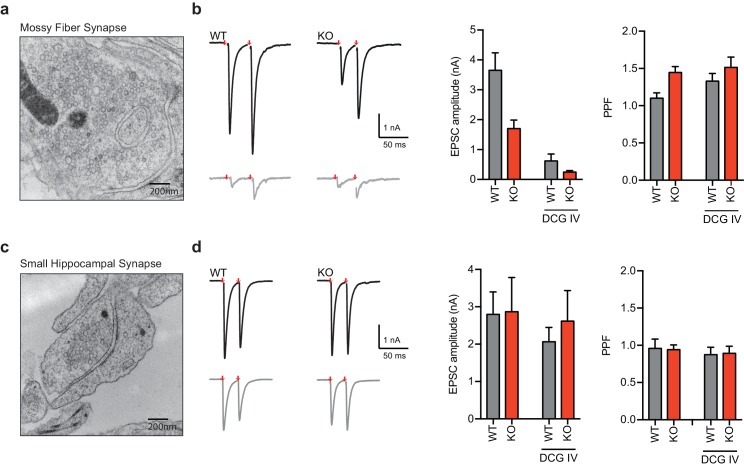
Characterization of autaptic granule cells.(a) Representative EM image of a granule cells in culture. (b) Sample traces and summary graphs of evoked EPSCs of granule cells with an interstimulus interval of 25 ms before (black) and after DCG IV application (gray) of RIM-BP2 WT and KO neurons. Both WT and KO neurons respond to the DCG IV application. EPSC amplitudes were reduced in RIM-BP2 KO neurons. (c) Representative EM image of a small central synapse in culture. (d) Sample traces and summary graphs of evoked EPSCs of hippocampal autaptic neurons with an interstimulus interval of 25 ms from RIM-BP2 WT and KO neurons that did not respond to DCG IV application. Autaptic neurons that do not respond to DCG IV application showed no reduction in EPSC amplitude in RIM-BP2 KO autapses compared to WT.